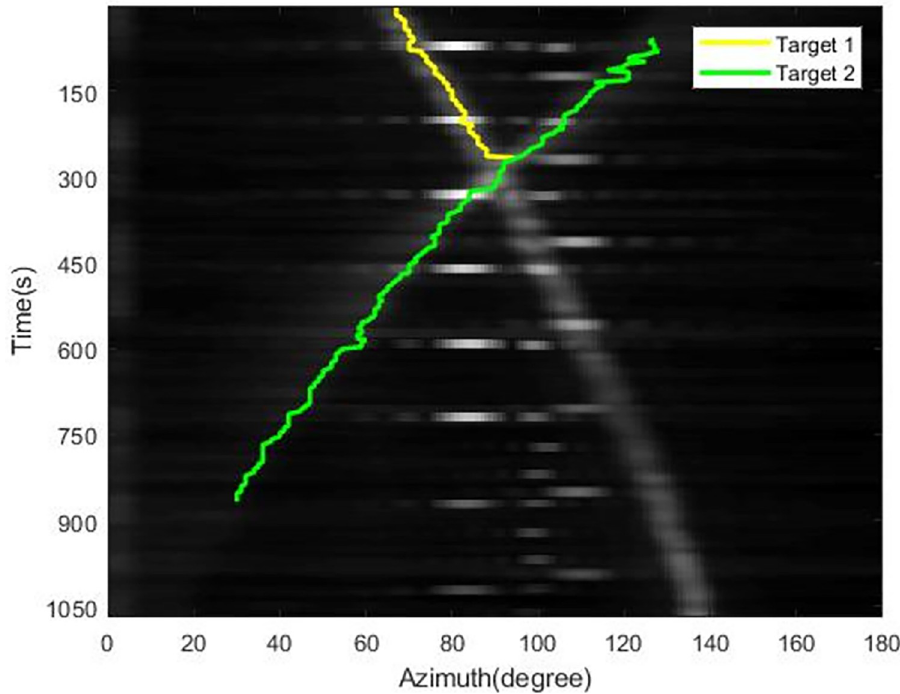
Fig 23. Tracking results of the EKF-Max method.